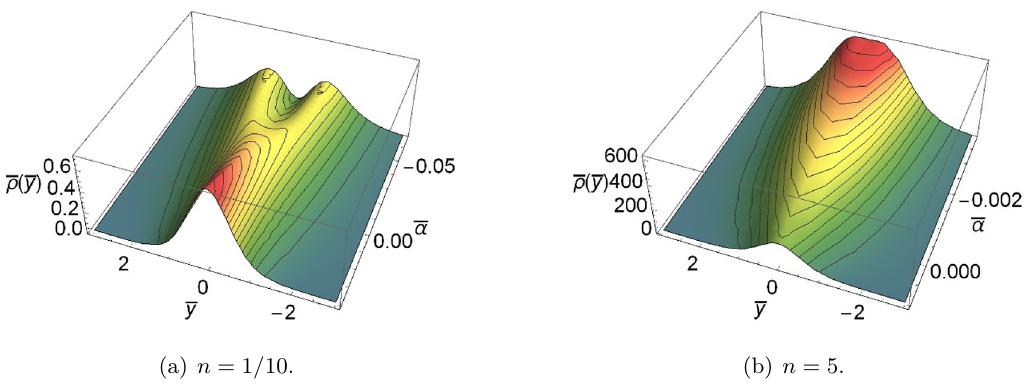
Figure 6 . Plots of the dimensionless energy density ¯ ρ (¯ y ) for the solution (5.10) regarding two values of n